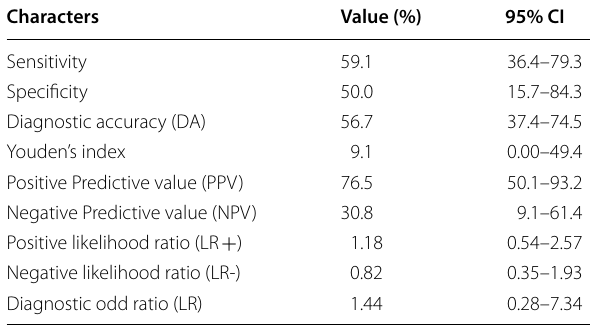
Table 15 Diagnostic characteristics of MRI DCE findings (non- specific considered negative) in diagnosing prostate malignancy